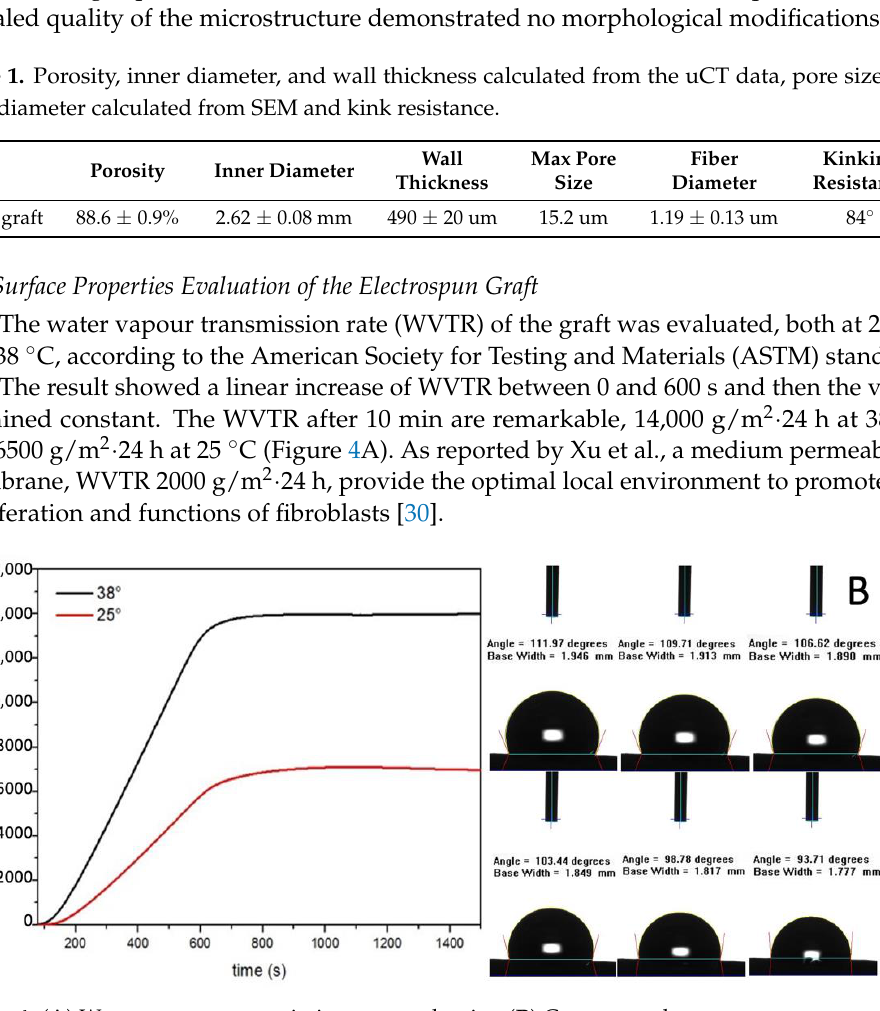
Figure 4. ( A ) Water vapour transmission rate evaluation ( B ) Contact angle measurements.